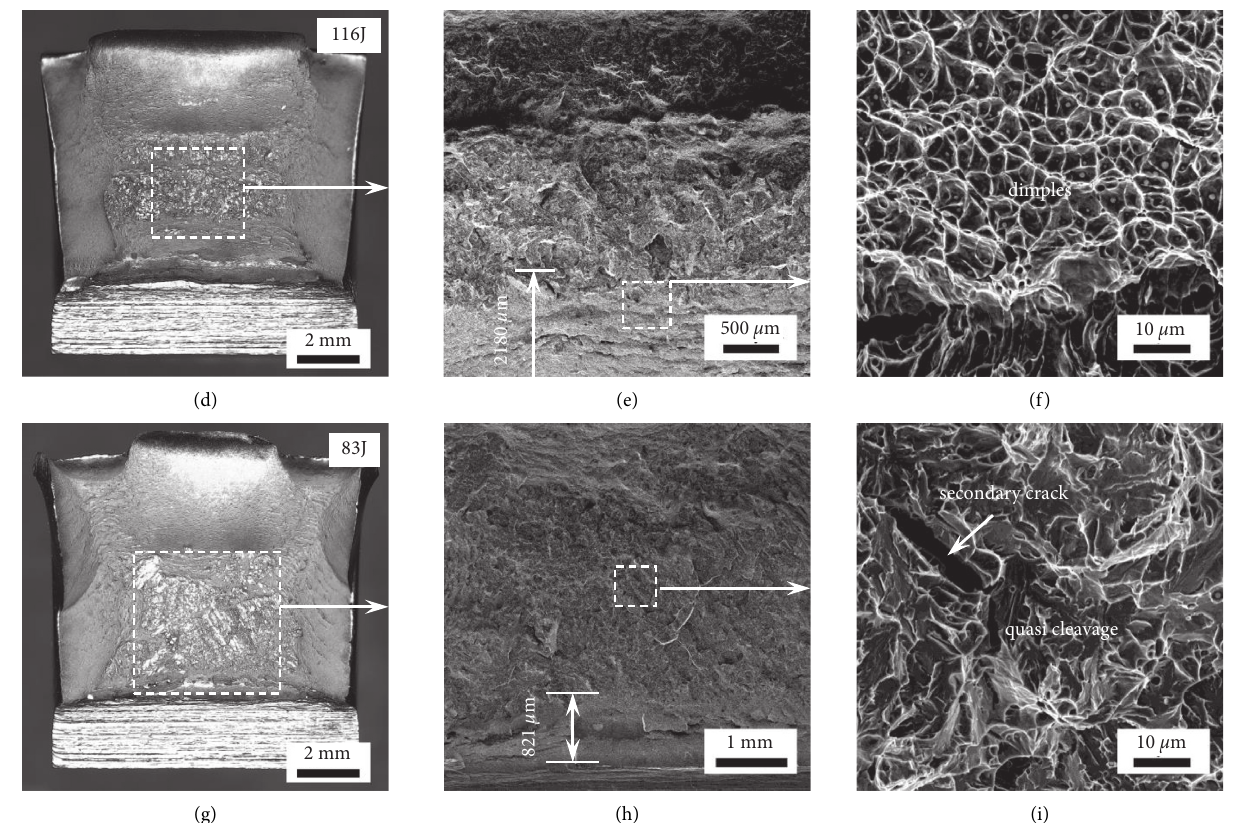
Figure 8: Properties and fractography of impact tests. (a) Impact absorbed energy; (b) typical load-displacement curves of the deposit; (c) enlarged image of the rectangle enclosed by white dashed line in (b); macroscopic (d) and microscopic (e, f) morphology of Y-Z-1; macroscopic (g) and microscopic (h, i) morphology of